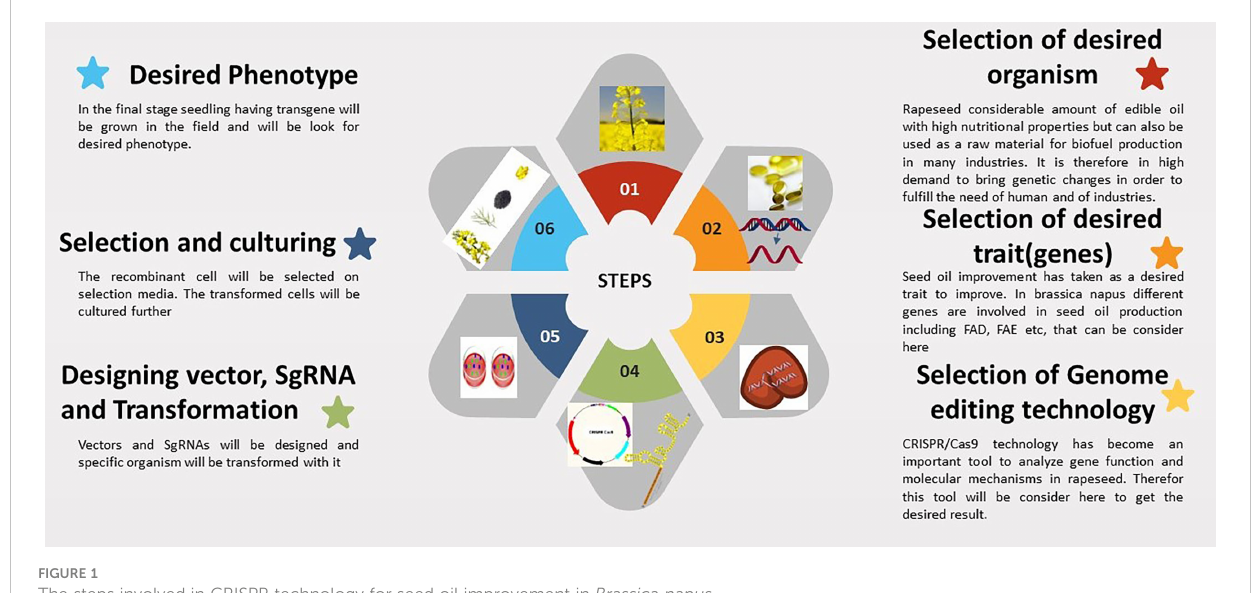
FIGURE 1 The steps involved in CRISPR technology for seed oil improvement in Brassica napus